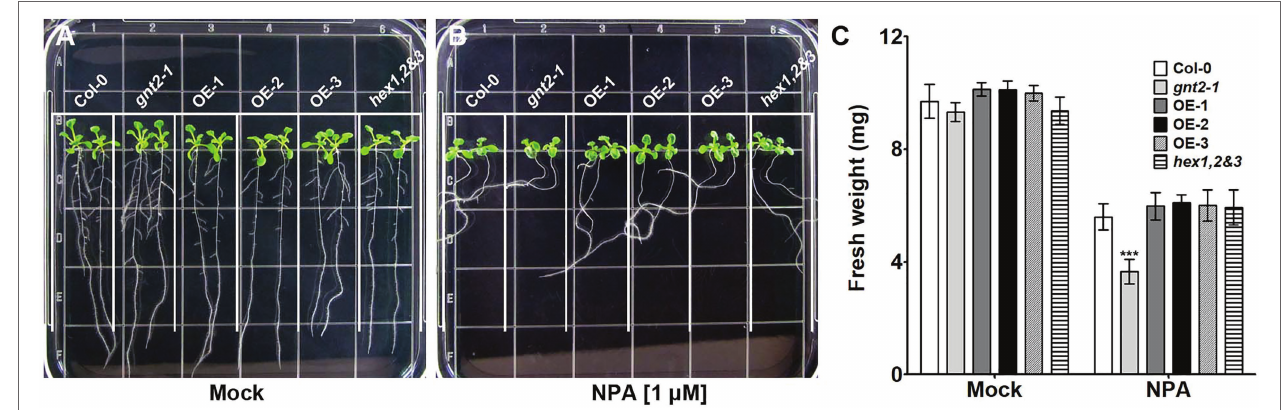
FIGURE 7 | The gnt2-1 mutant exhibits increased sensitivity to inhibition by NPA. (A,B) Representative photographs of Arabidopsis seedlings grown vertically on tissue culture plates containing solidified MS medium (A) or MS medium supplemented with 1 μ m NPA (B) , taken 12 day after plating. The grid on the square plate is 18 × 18 mm. (C) Fresh weight of Col-0, gnt2-1 , OE-1, OE-2, OE-3, and hex1,2&3 plants grown in the absence or presence of NPA. Asterisks indicate statistically significant differences (* p < 0.05, ** p < 0.01, and *** p < 0.001) as determined by two-way